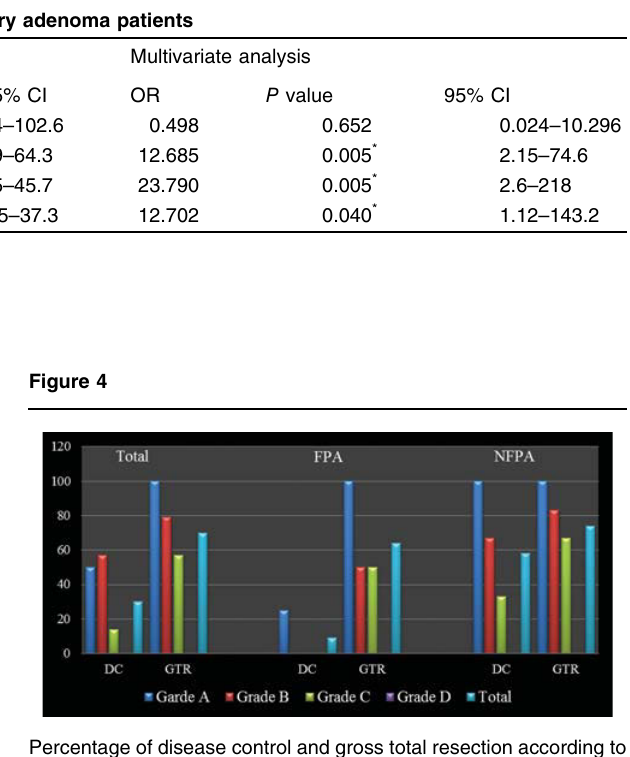
Percentage of disease control and gross total resection according to suprasellar extension